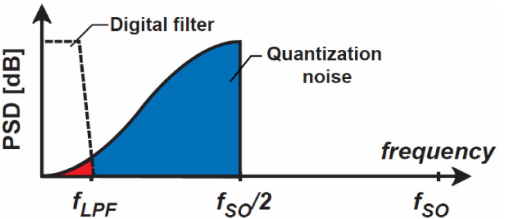
Figure 5. Noise transfer function of delta-sigma